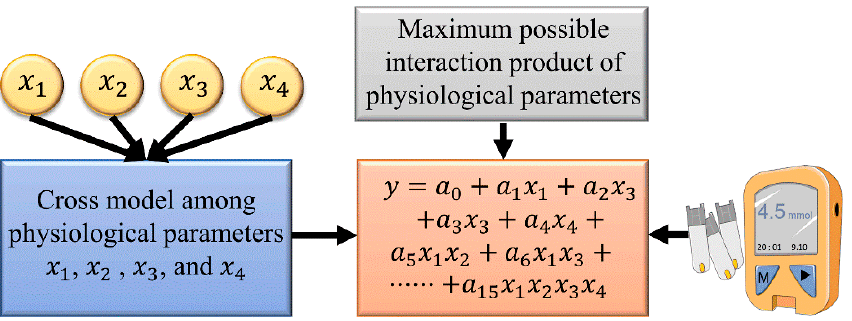
Figure 5. The MPR4 model used for prediction.